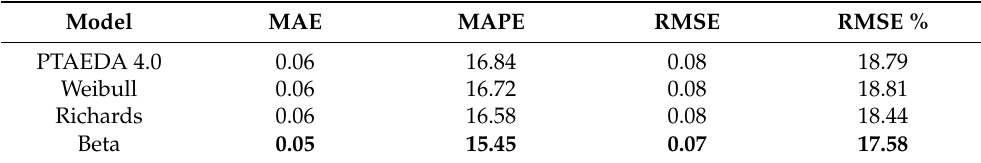
Table 4. Evaluation statistics produced by different models for predicting crown ratio of loblolly pine. Smallest values are preferred, and the best results are given in bold .